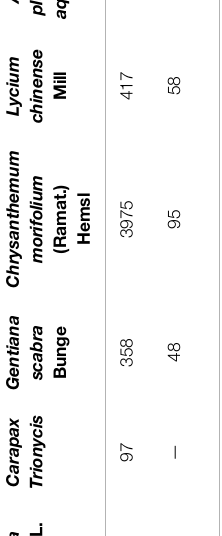
Figure 1C . A total of 133 KEGG pathways were enriched, which were associated with key candidate targets. The top 20 pathways were sorted by P -value, as shown in Figure 1D